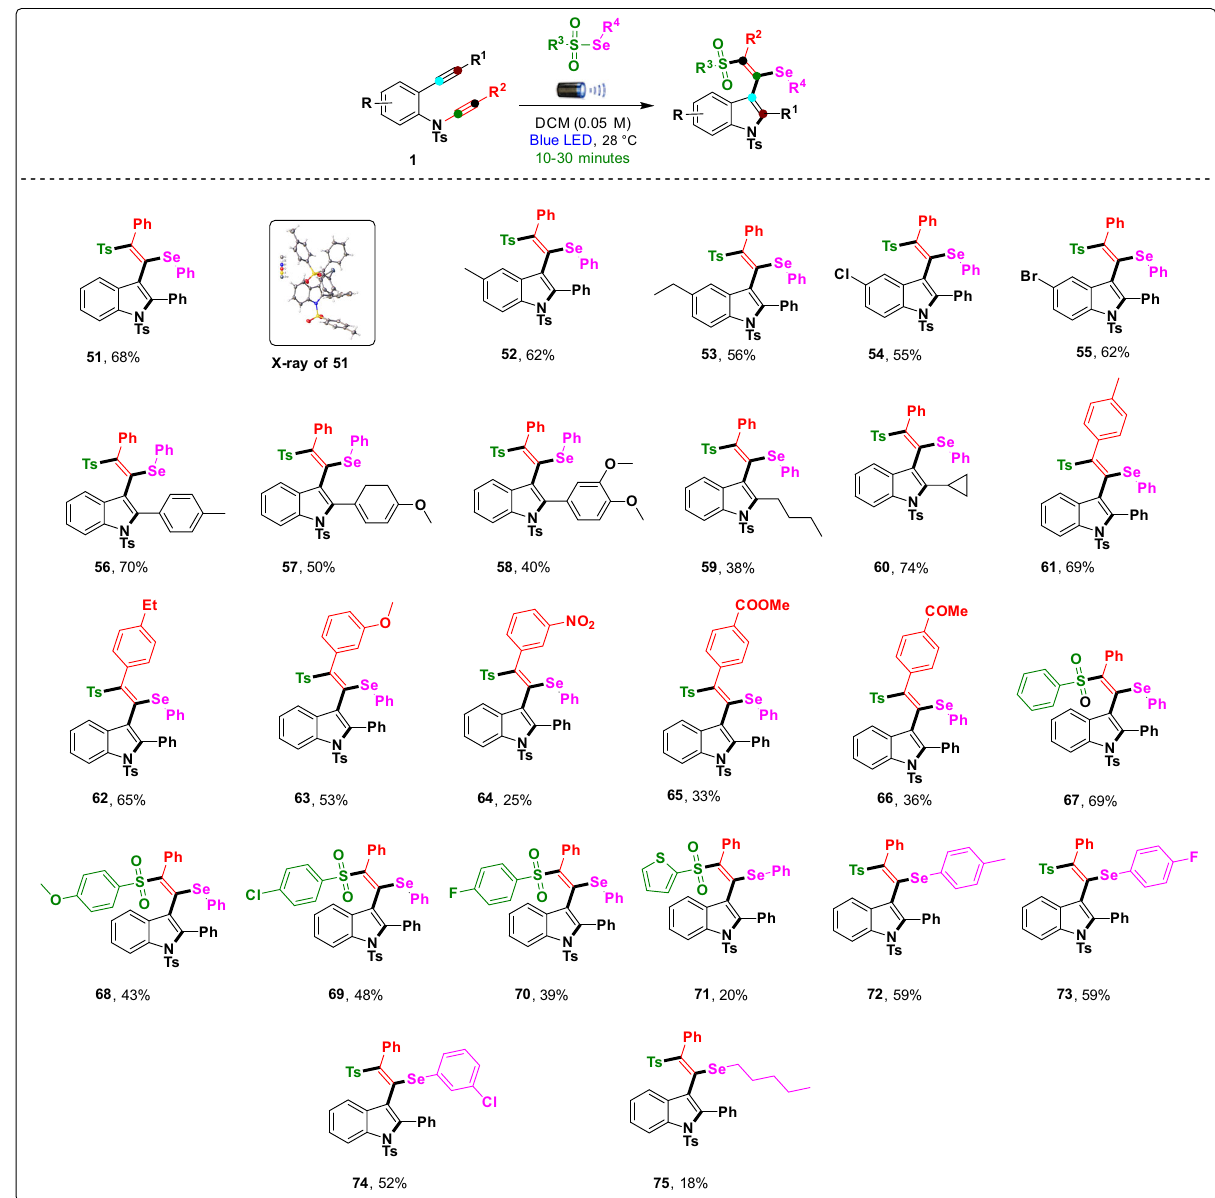
Fig. 5 Substrate scope of 2-alkynyl-ynamides and areneselenosulfonates. Reaction conditions: 2-alkynyl-ynamides 1 (0.1 mmol), areneselenosulfonates (0.11 mmol), and DCM (0.05 M) were stirred at 28 °C under irradiation with a 40 W Kessil blue LED lamp (Kessil A160WE Tuna Blue, λ max = 462 nm fl anked by a second peak at λ = 382 nm) and cooled with a fan, and reaction vessels were placed ~8.5 cm from the LED light for 10 – 30 min; isolated